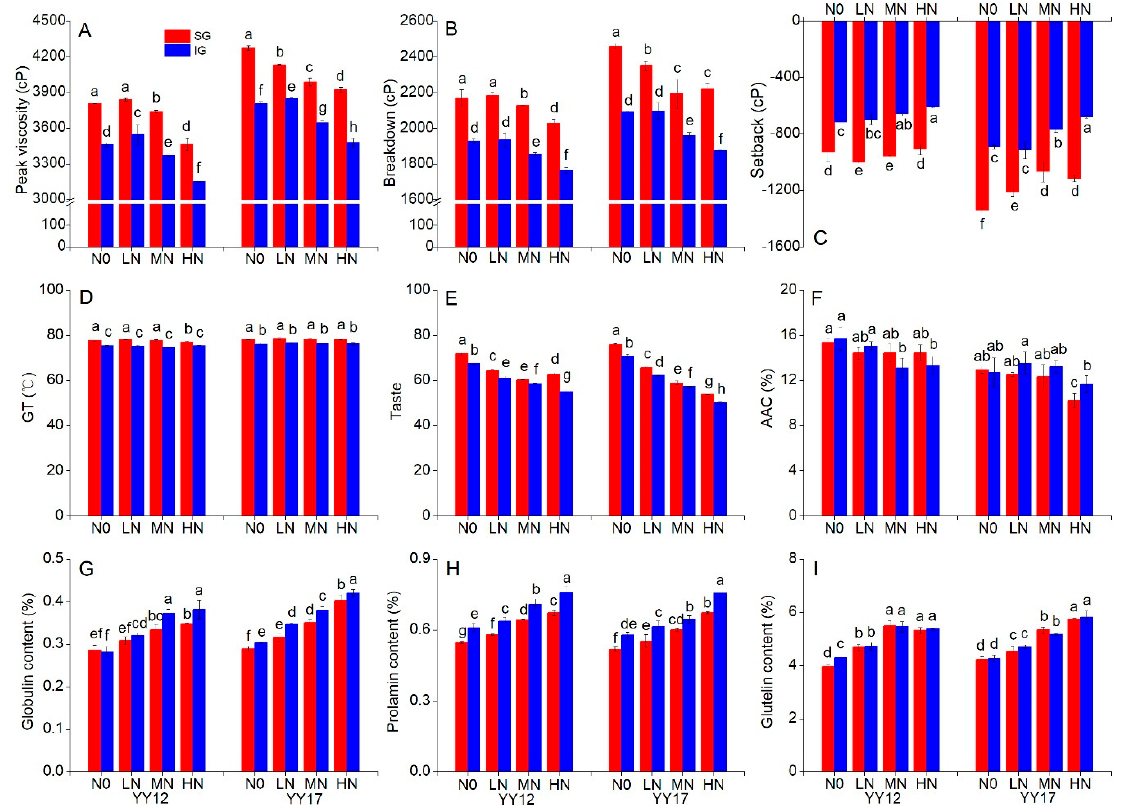
Figure 1. The peak viscosity ( A ), breakdown ( B ), setback ( C ), gelatinization temperature ( D ), taste ( E ), apparent amylose content ( F ), globulin content ( G ), prolamin content ( H ) and glutelin content ( I ) of the superior and inferior grains under different nitrogen levels. YY12, Yongyou12; YY17, Yongyou17; SG, superior grains; IG, inferior grains; GT, gelatinization temperature; AAC, apparent amylose content; N0, control; LN, low nitrogen; MN, medium nitrogen and HN, high nitrogen. Di ff erent letters labeled on the columns in the same cultivar are significantly di ff erent ( p < 0.05).